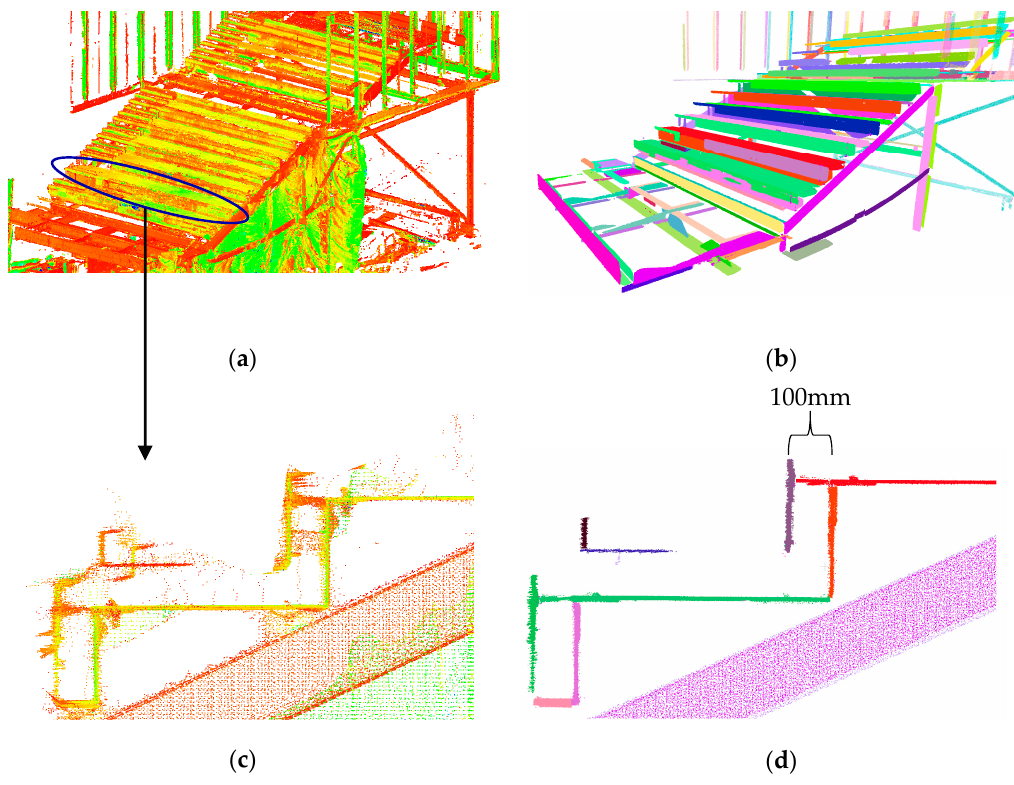
Figure 14. ( a ) Point cloud of the staircase; ( b ) robust planar segmentation results of the staircase; ( c ) point cloud of the random subset of ( a ); and ( d ) planar segmentation results of the point cloud of ( c ).